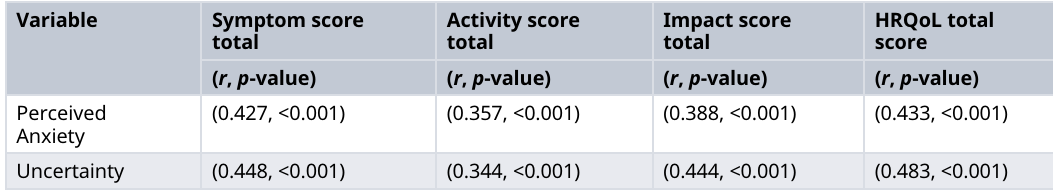
Table 4. Correlations matrix between HRQoL, anxiety and